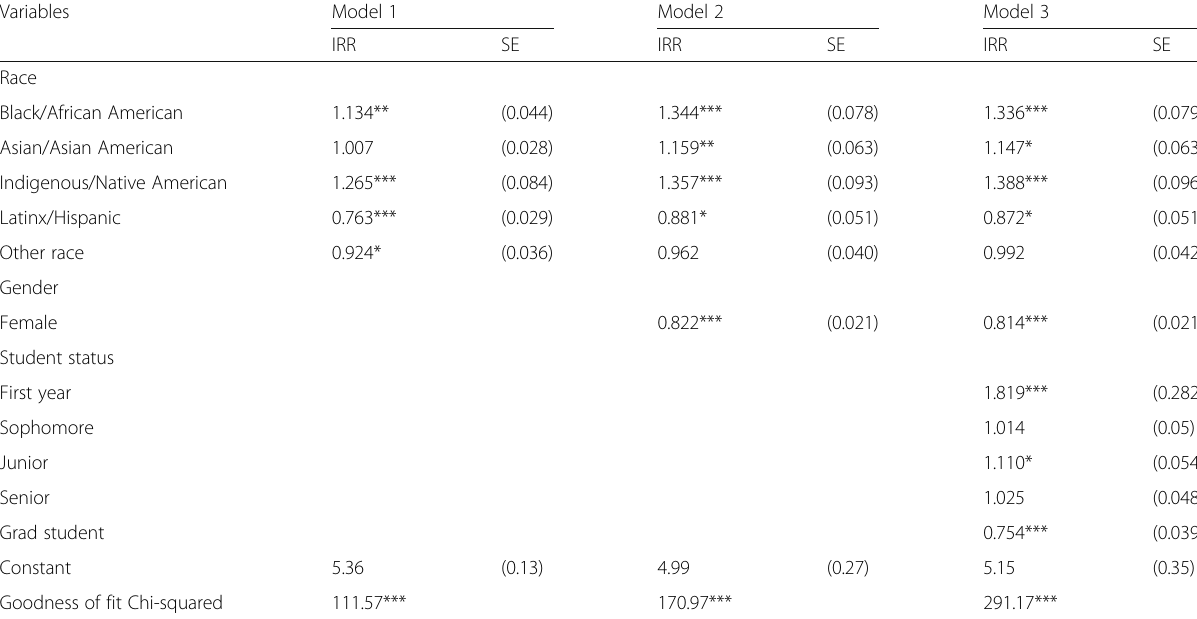
Table 5 Poisson regression predicting peer level microaggressions for all STEM students surveyed